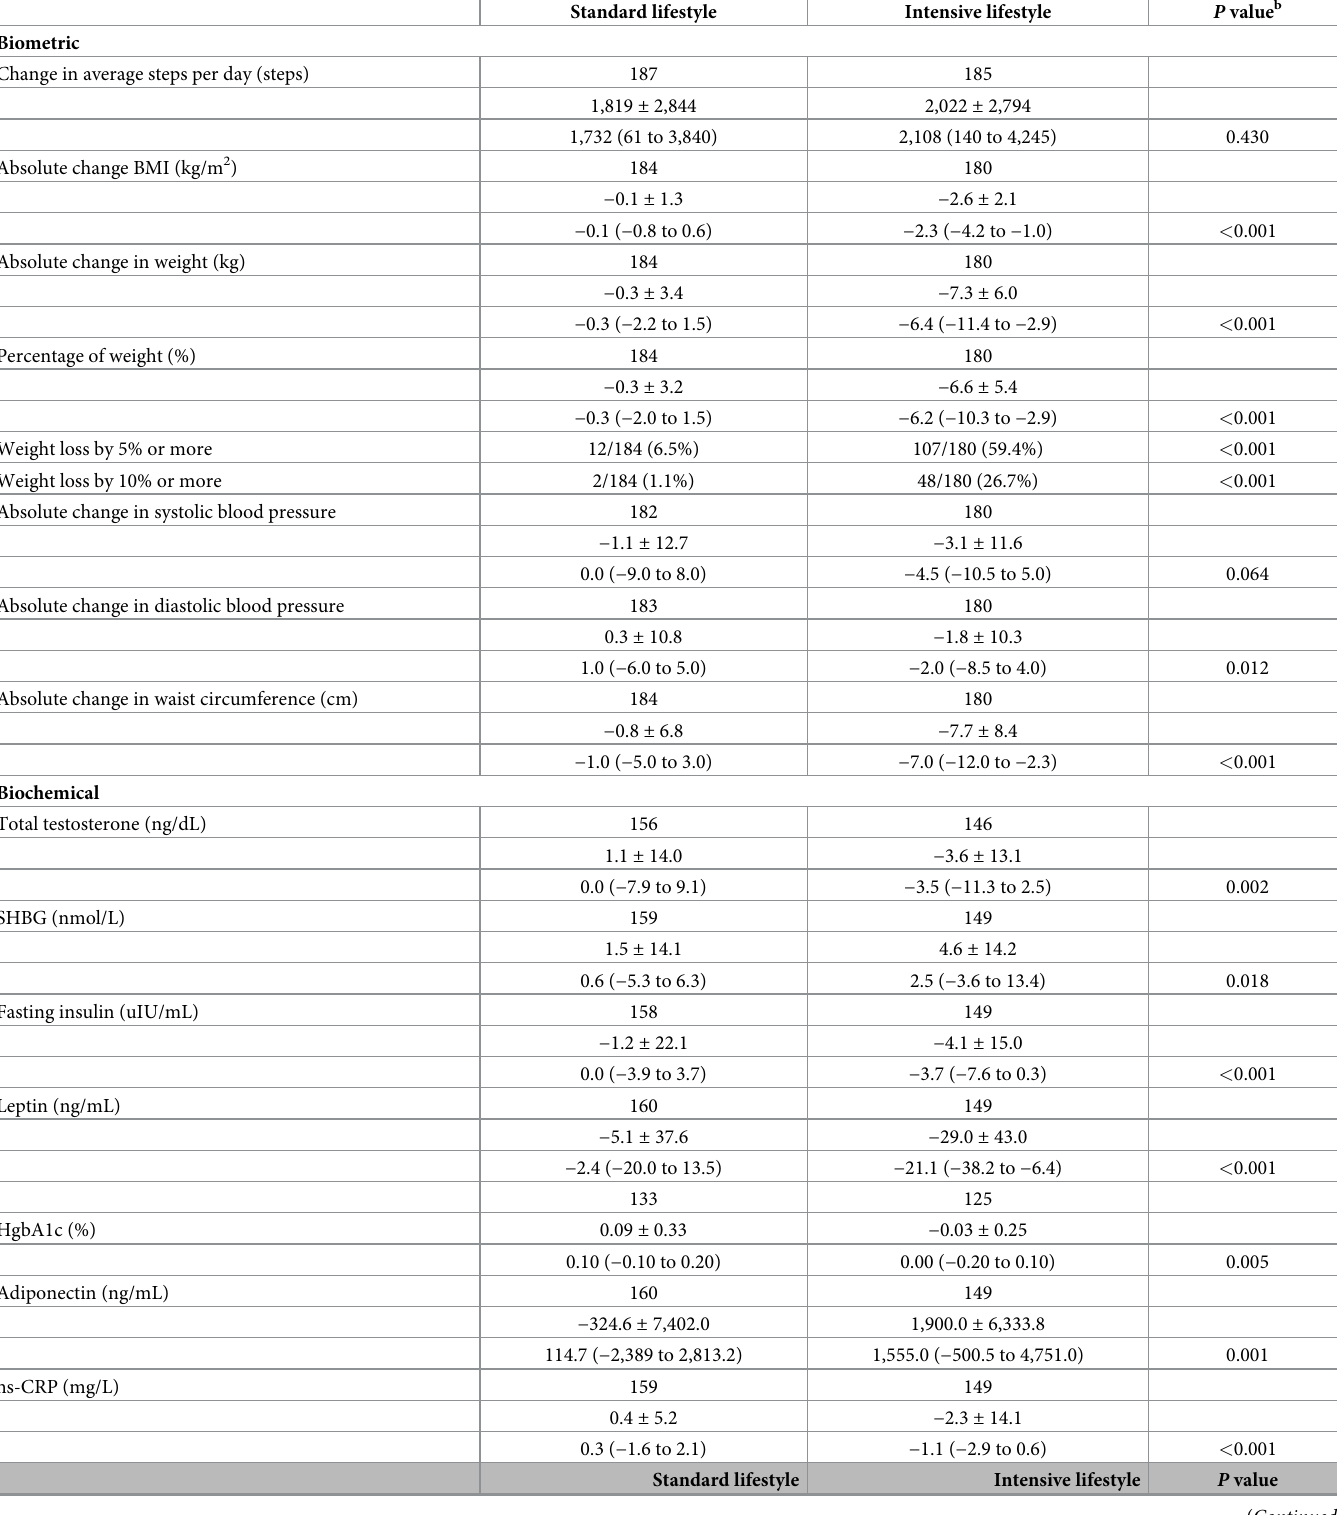
Table 2. Effect of 16-week lifestyle intervention programs on biometric and biochemical